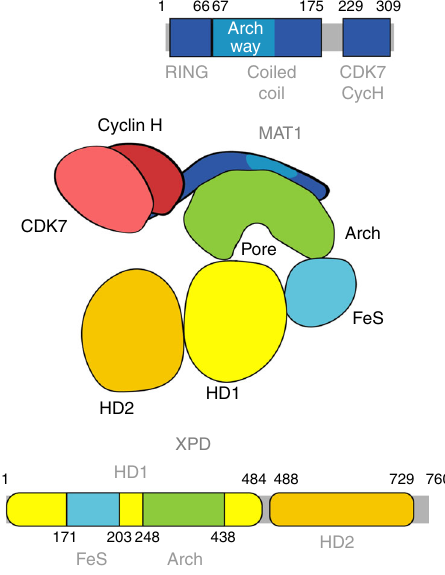
Fig. 1 Cartoon representation of human XPD and human CAK. The domain architecture of XPD and MAT1 within the linear sequence of the two proteins is shown. The location of the different domains is indicated and labeled. A schematic of the CAK – XPD complex utilizing the same colors as in the linear sequence cartoon is shown with Cyclin H and CDK7 in two different